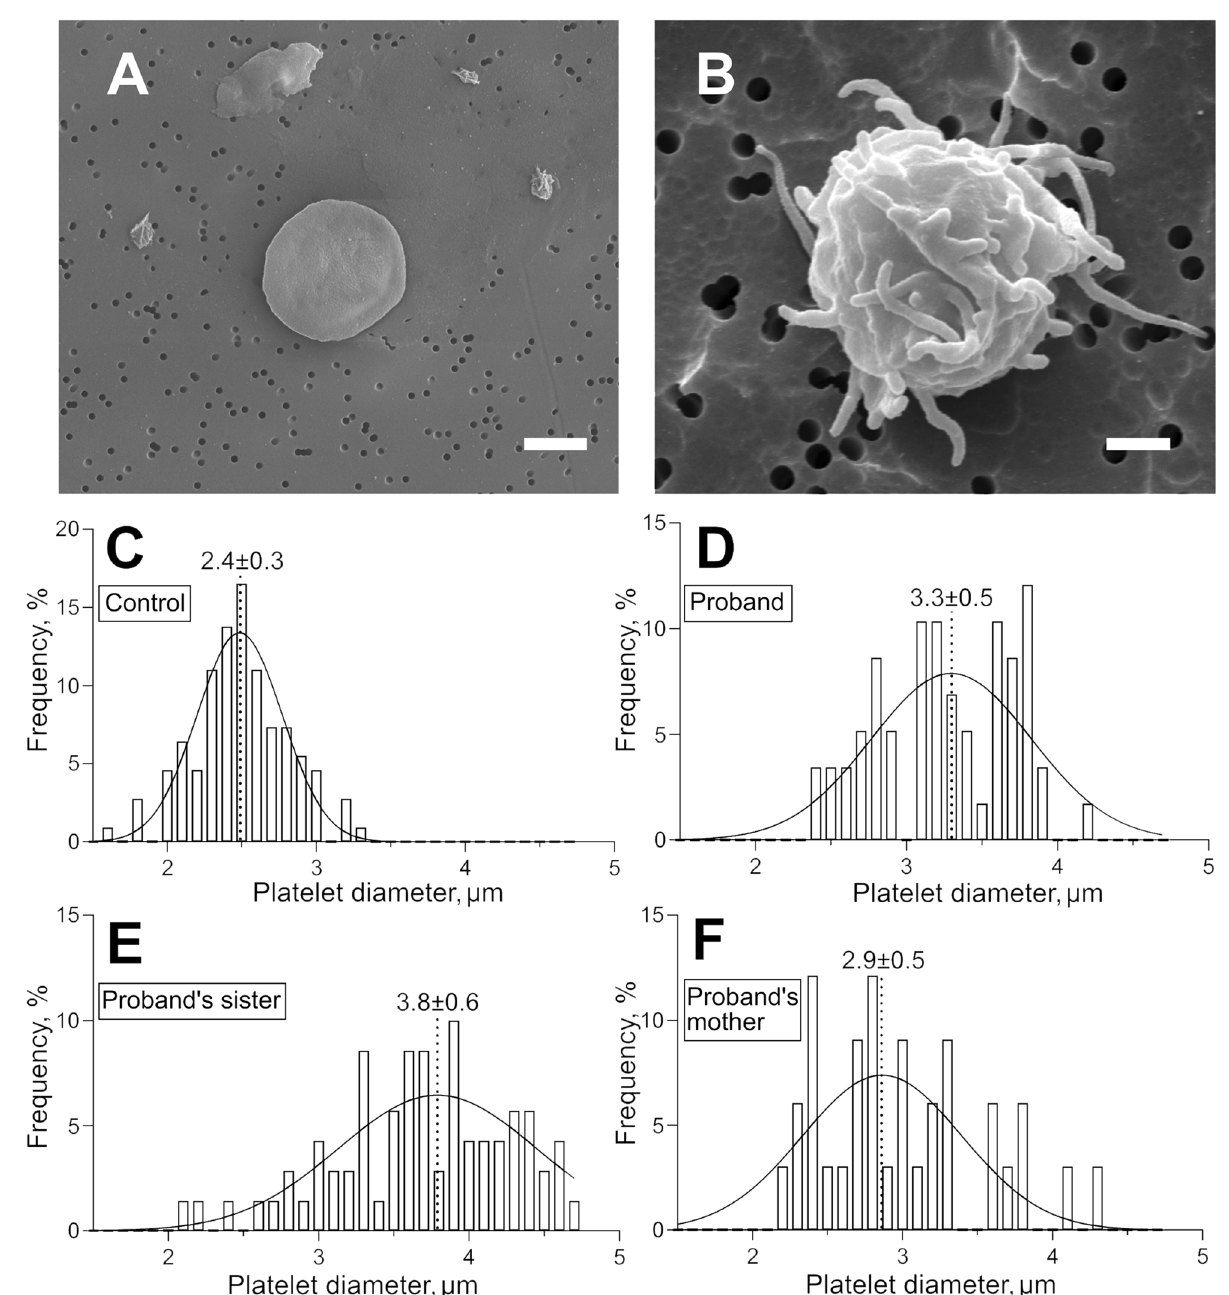
Figure 3. Characteristic scanning electron micrographs of platelets from a healthy donor ( A ) and the sister of proband with a MYH9 gene mutation ( B ). In ( A ): the typical morphology of a normal resting platelet: normal size, discoid shape, absence of filopodia. In ( B ): a typical platelet from a patient with a MYH9 -related disorder with morphological signs of activation: large size, loss of discoid shape, formation of multiple filopodia. Magnification bars = 1 µm. ( C – F ) Histograms of platelet diameters fitted with a Gaussian function (solid line) in a control healthy donor ( C ) and in the patients with a MYH9 gene mutation ( D – F ). In ( C – F ) the Gaussian peak centroids and standard deviations are